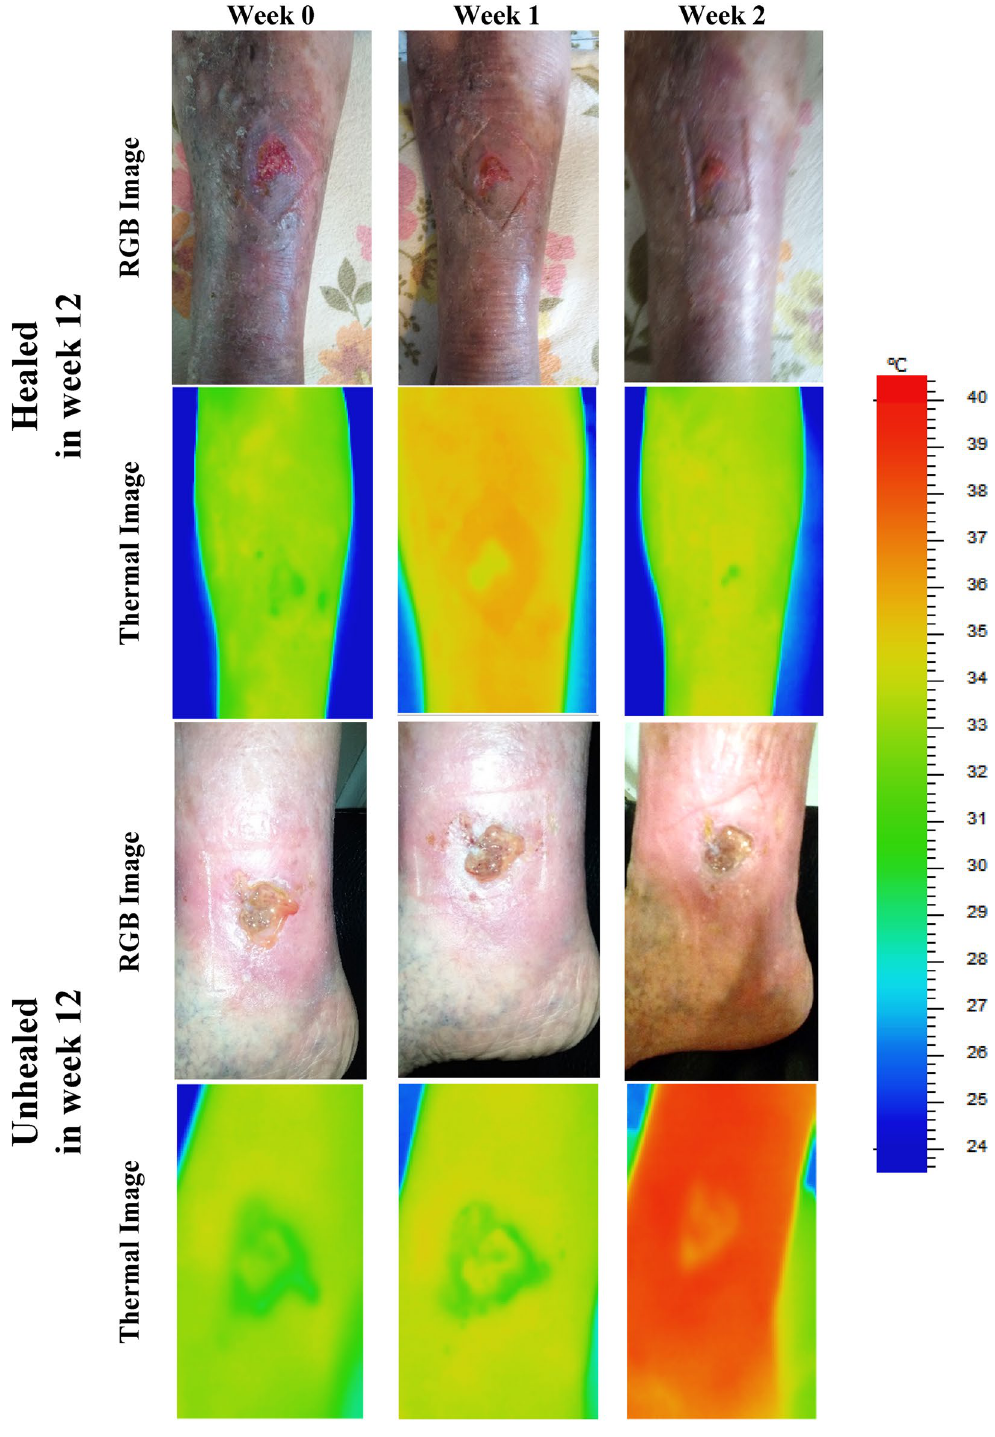
Figure 5. Sample images (RGB and Thermal) of healed and unhealed cases across three consecutive weeks showing the healing